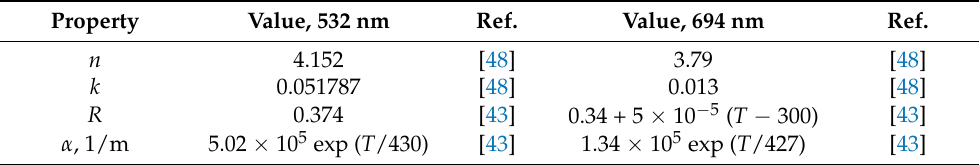
Table A2. c -Si—optical properties. Property